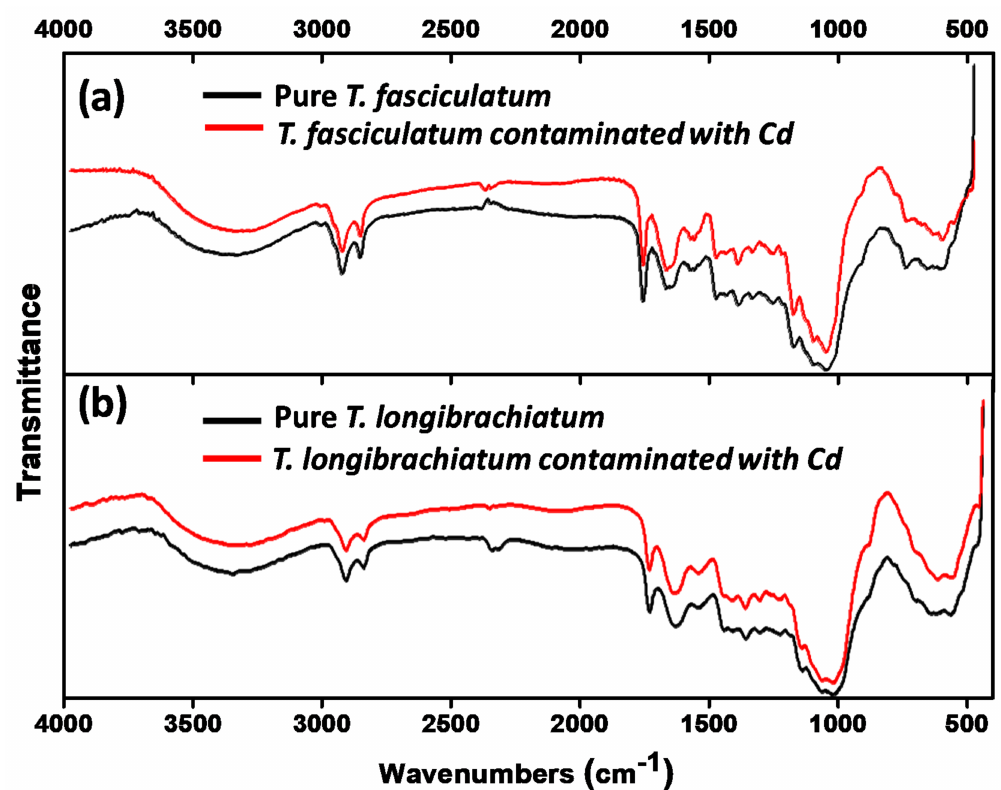
Figure 4. Fourier transform infrared spectroscopy (FTIR) spectra of ( a ) T. fasciculatum and ( b ) T. longibrachiatum fungal biomass before and after treatment with Cd 2 +